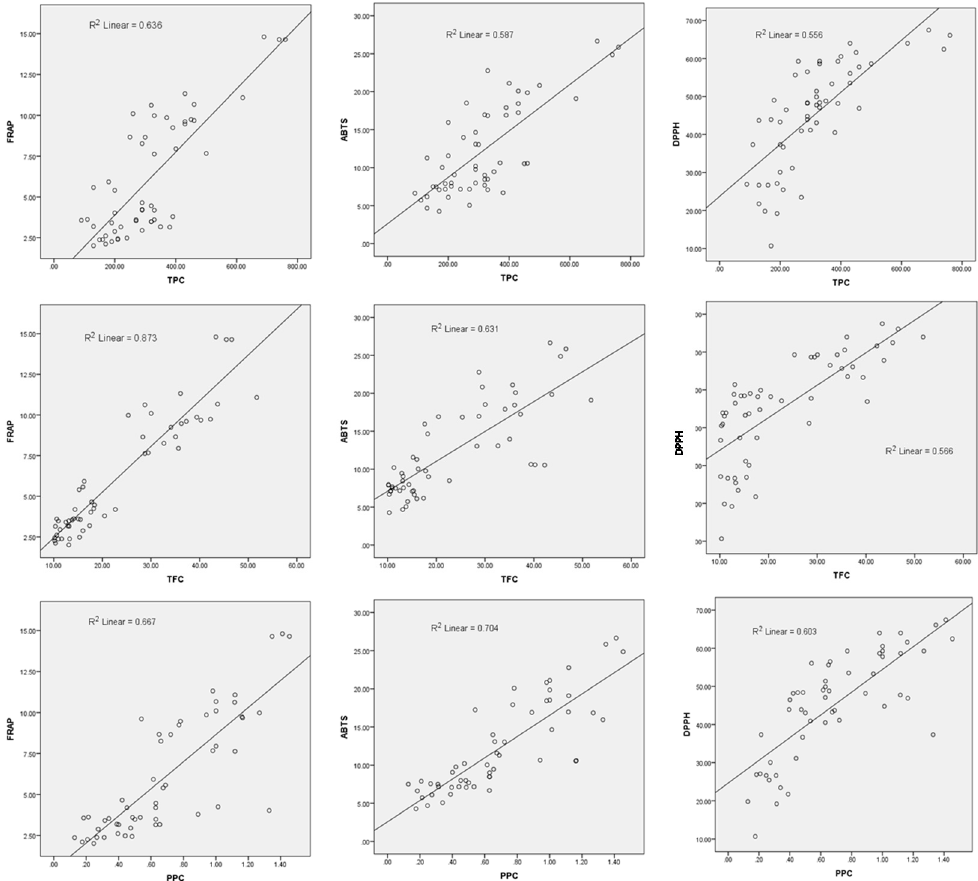
Figure 5. Correlations between the antioxidant capacity assay and total phenolic content, total flavonoid content and protein-precipitating capacity. Abbreviations: TPC—total phenolic content; GAE—gallic acid equivalent; QE—quercetin equivalent; TFC—total flavonoid content; DPPH—2,2- diphenyl-1-picrylhydrazyl; FRAP—ferric reducing antioxidant power; ABTS—2,2 ′ -azino-bis(3- ethylbenzothiazoline-6-sulfonic acid). Table 9. Pearson correlation coefficients for the interaction between TPC, TFC, PPC and the antioxidant capacity of the cider variants (expressed by ABTS, FRAP values and DPPH % inhibition values).